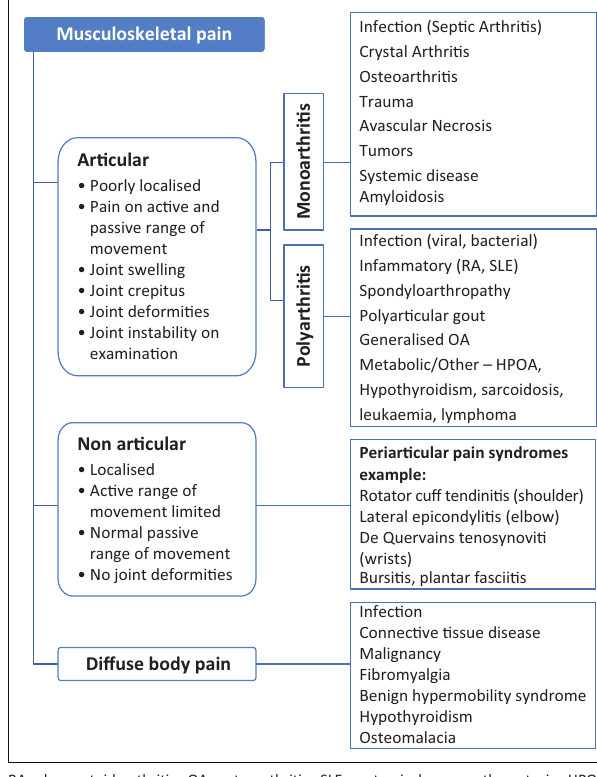
FIGURE 1: Approach to musculoskeletal pain.